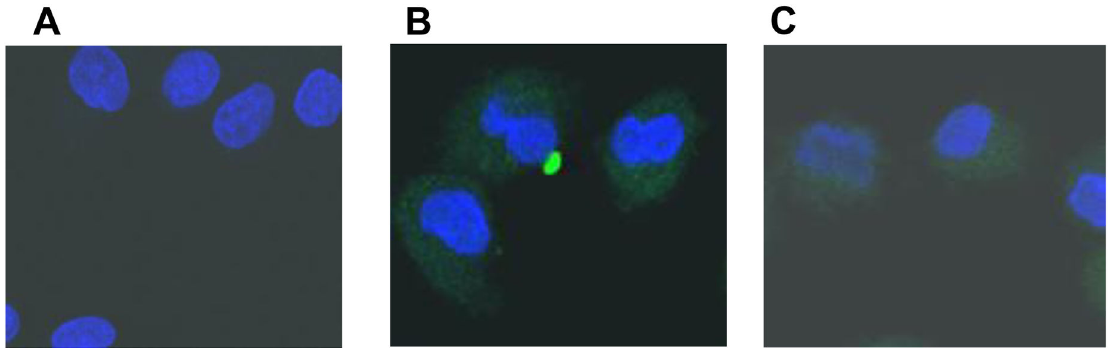
Figure 2. β -AR Abs from HF patients bound to β 3 labeled with DAPI (blue). B. The positive control. Nuclei (blue), β C. The experiment group. Nuclei (blue), β